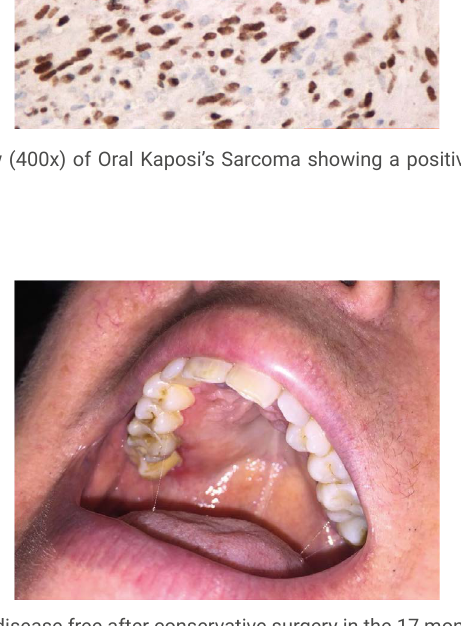
Figure 4. Patient remains disease free after conservative surgery in the 17 months